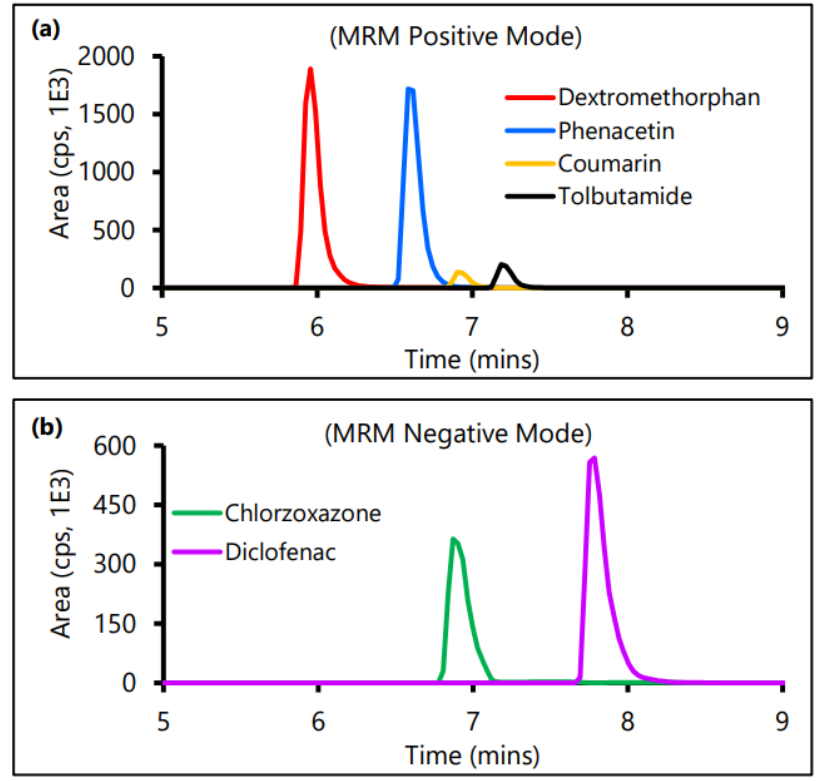
Figure 2. Multiple reaction monitoring (MRM) chromatograms of control CYP substrates. ( a ) Posi- tive mode, ( b ) negative